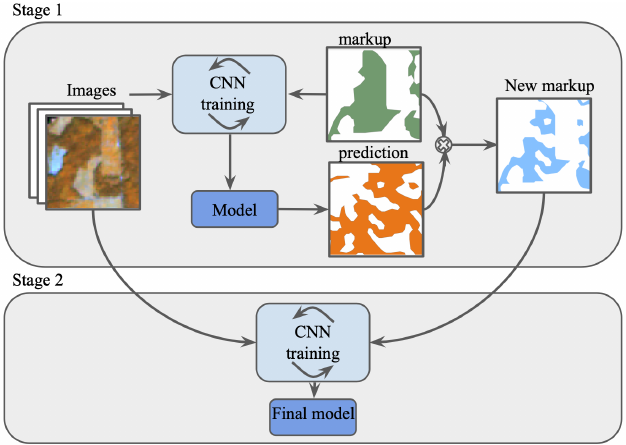
Figure 8. Markup adjustment